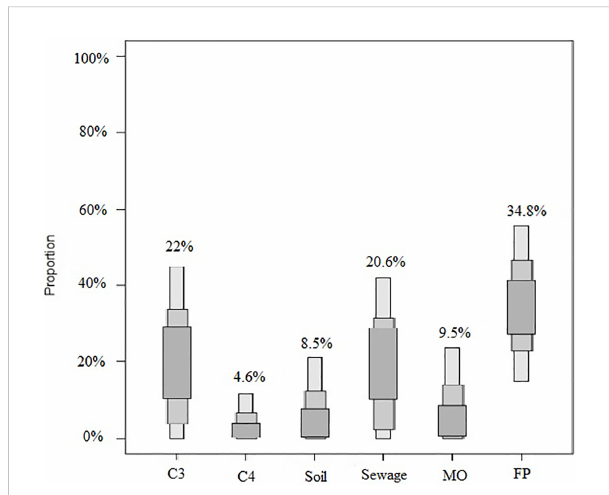
FIGURE 7 Relative contribution of potential POM sources in the northern Beibu Gulf. The credibility intervals of the model (95, 75, and 25%) are shown in dark, medium, and light gray coloring, respectively. MO, marine organic matter; FP, freshwater